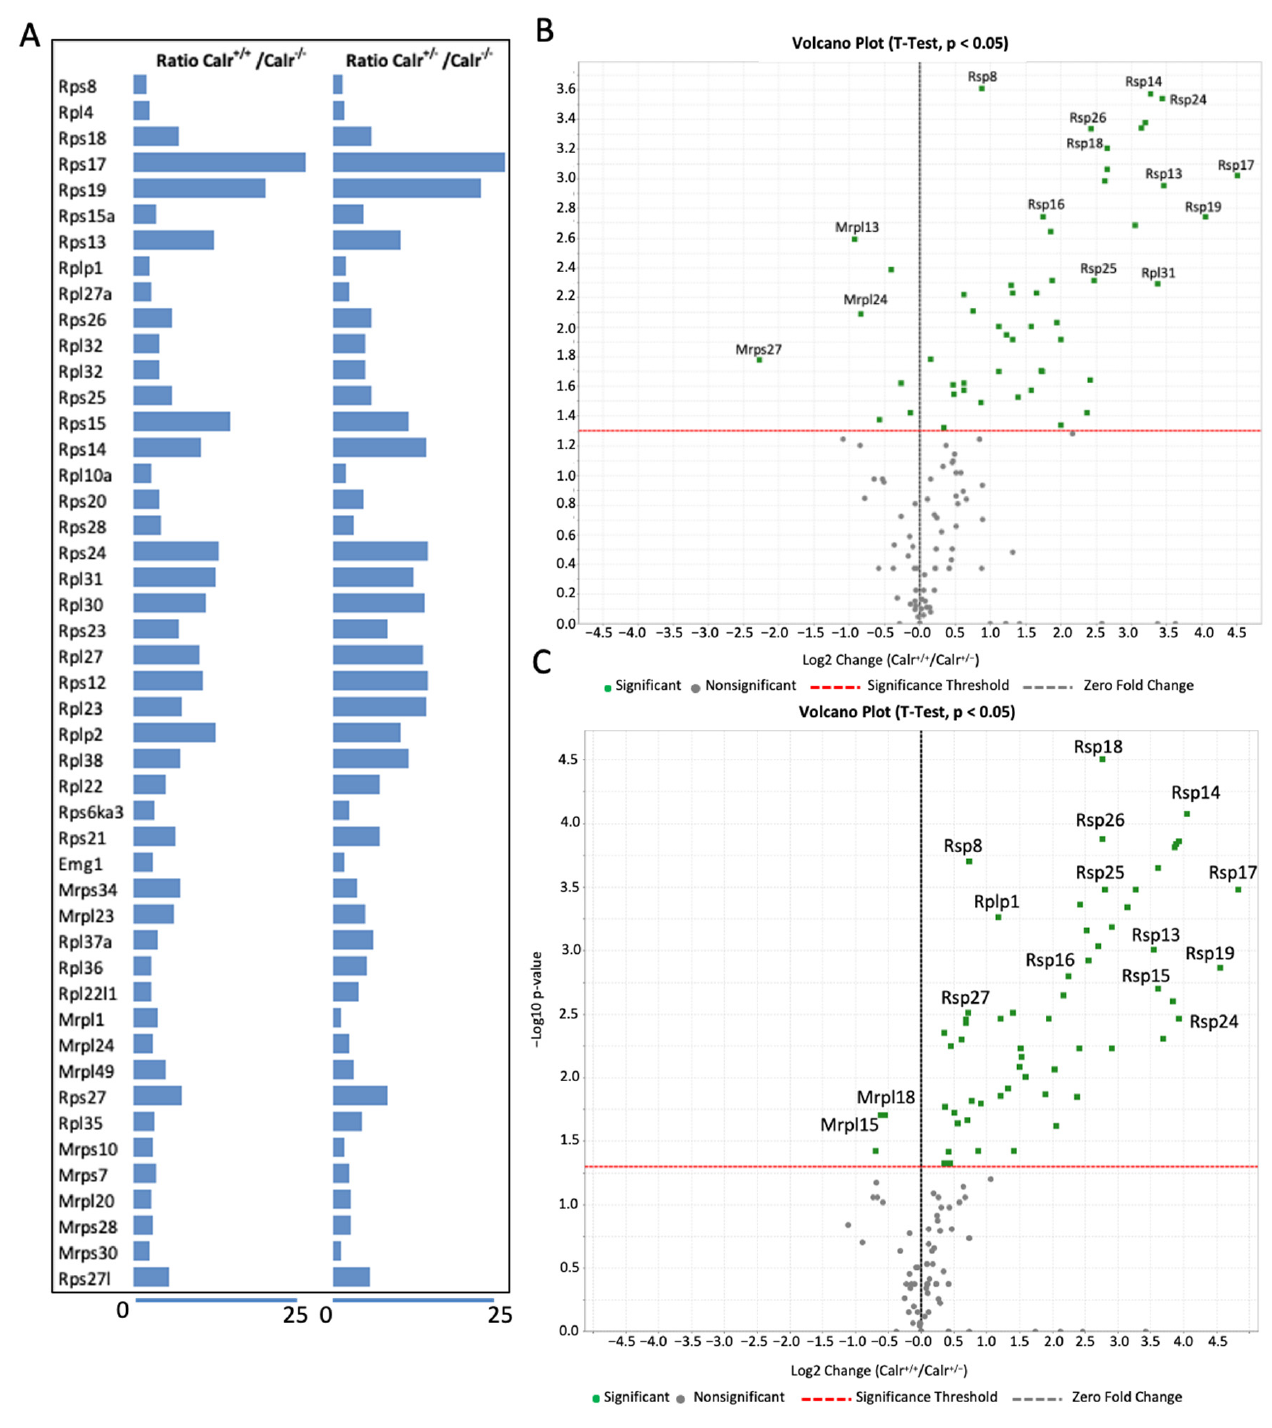
Figure 6. Figure 6. ( A ): The mass spectrometric based label free quantification permitted the identification of the ribosomal proteins found to be down-regulated in Carl − / − embryonic kidney. ( B , C ): Volcano plots illustrating the ribosomal proteins found to be up-regulated in Calr +/+ compared to Calr − / − ( B ) and in Calr +/ − compared to Carl − / − ( C ). Remarkably, several mitochondrial ribosomal proteins were up-regulated in Calr − / − . ( D ): Networking analysis of ribosomal protein found to be regulated in